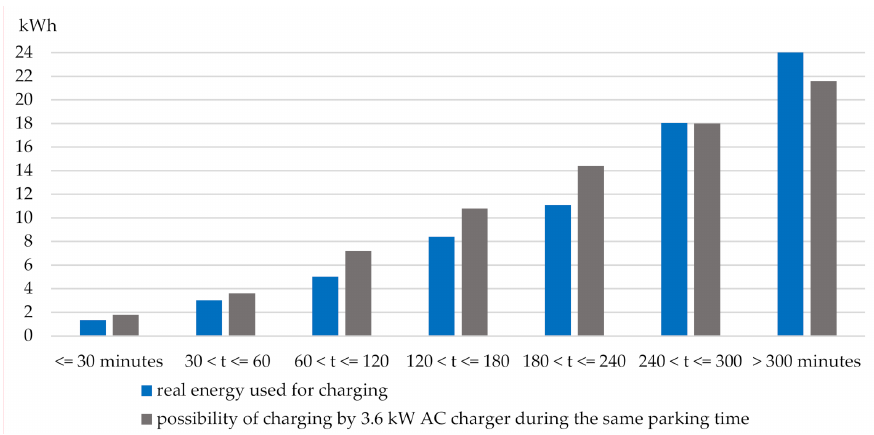
Figure 6. ŠKO-ENERGO charging stations ([34], calculated by